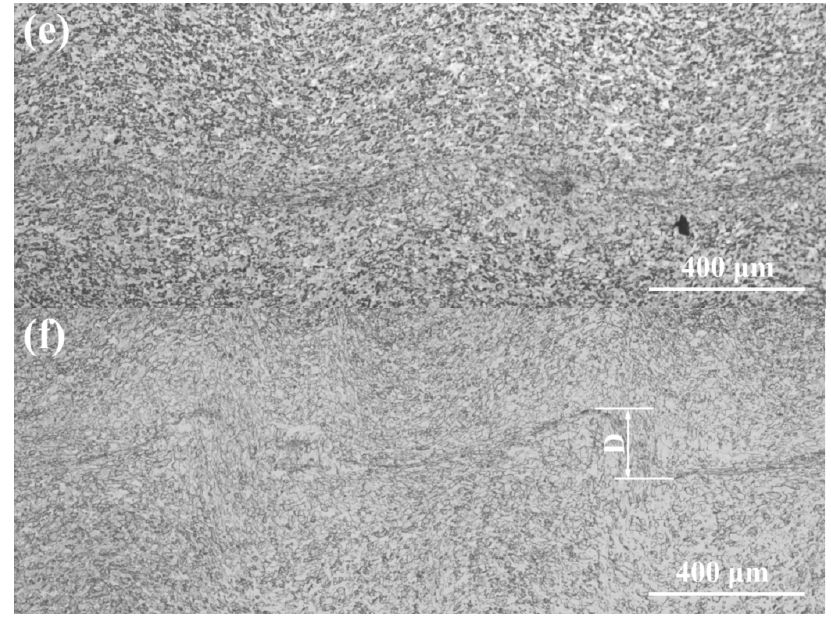
Figure 3. Enlarged regions of the bond zones from the weld cross-sections shown by the white boxes in Figure 1: ( a ) 400 J; ( b ) 800 J; ( c ) 1200 J; ( d ) 1600 J; ( e ) 2000 J and ( f ) 2400 J.